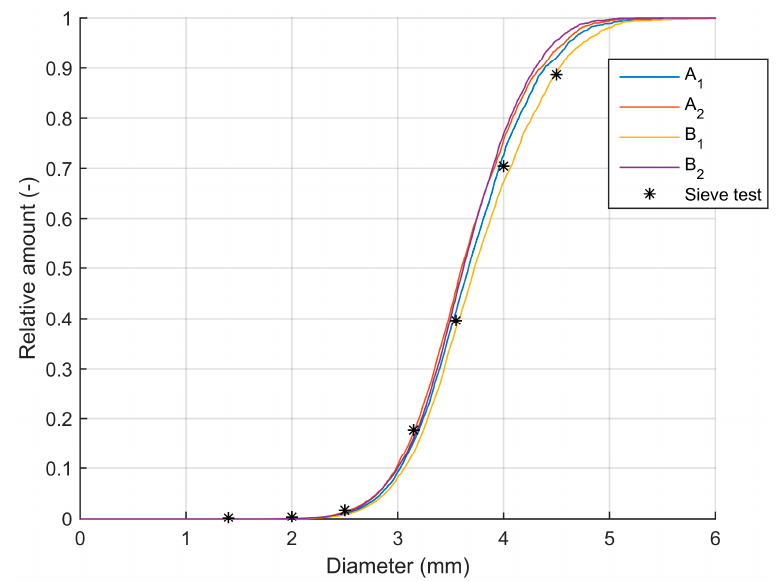
Figure 5. Cumulative particle size distribution (mass based). Results from image processing are given (two tests of configuration A and B), as well as the results of the sieve test.